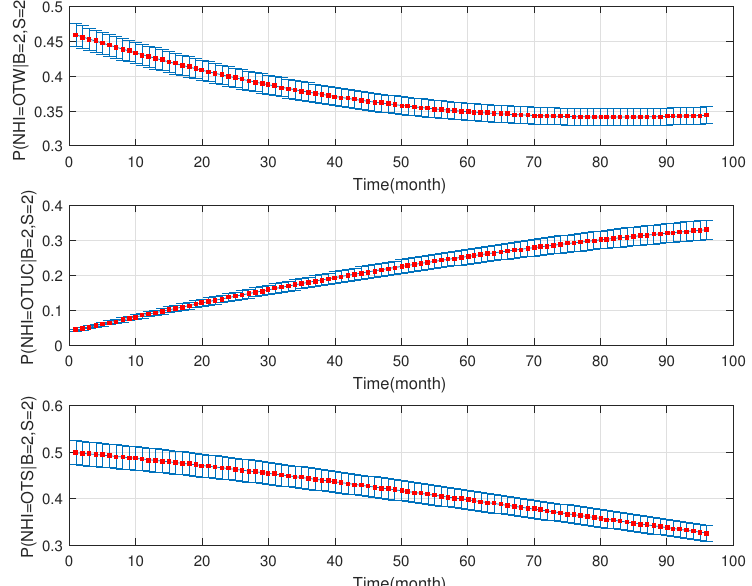
Figure 16. The probability of new herd incident (NHI) (officially TB free status withdrawn (OTW), officially TB free status unclassified (OTUC), officially TB free status suspended (OTS)) in high-risk areas of England where B: badgers density is ≤ 3 setts/ ha; S: there is no silage fed in the presence of the rest of risk factors (A: cattle are over 24 months; C: manure stored for more than six months; D: stock density is more than 3 head/km − 2 ; and W: the number of purchased cattle is more than 50 heads.